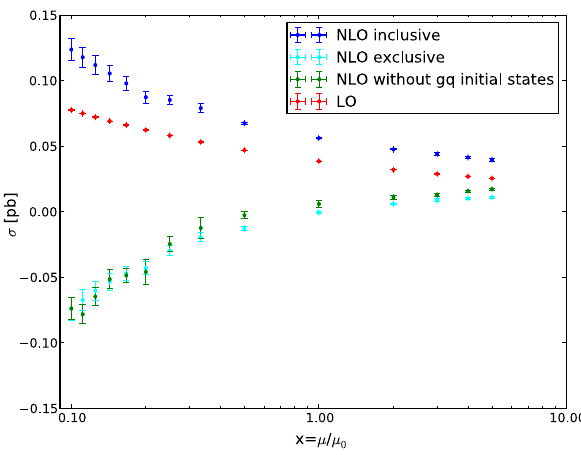
Fig. 1 Total cross sections at LO and NLO for massless b -quarks. In addition it shows the NLO cross section where the initial qg -channel has been removed as well as the exclusive two b -jet cross section where a veto on a third jet has been